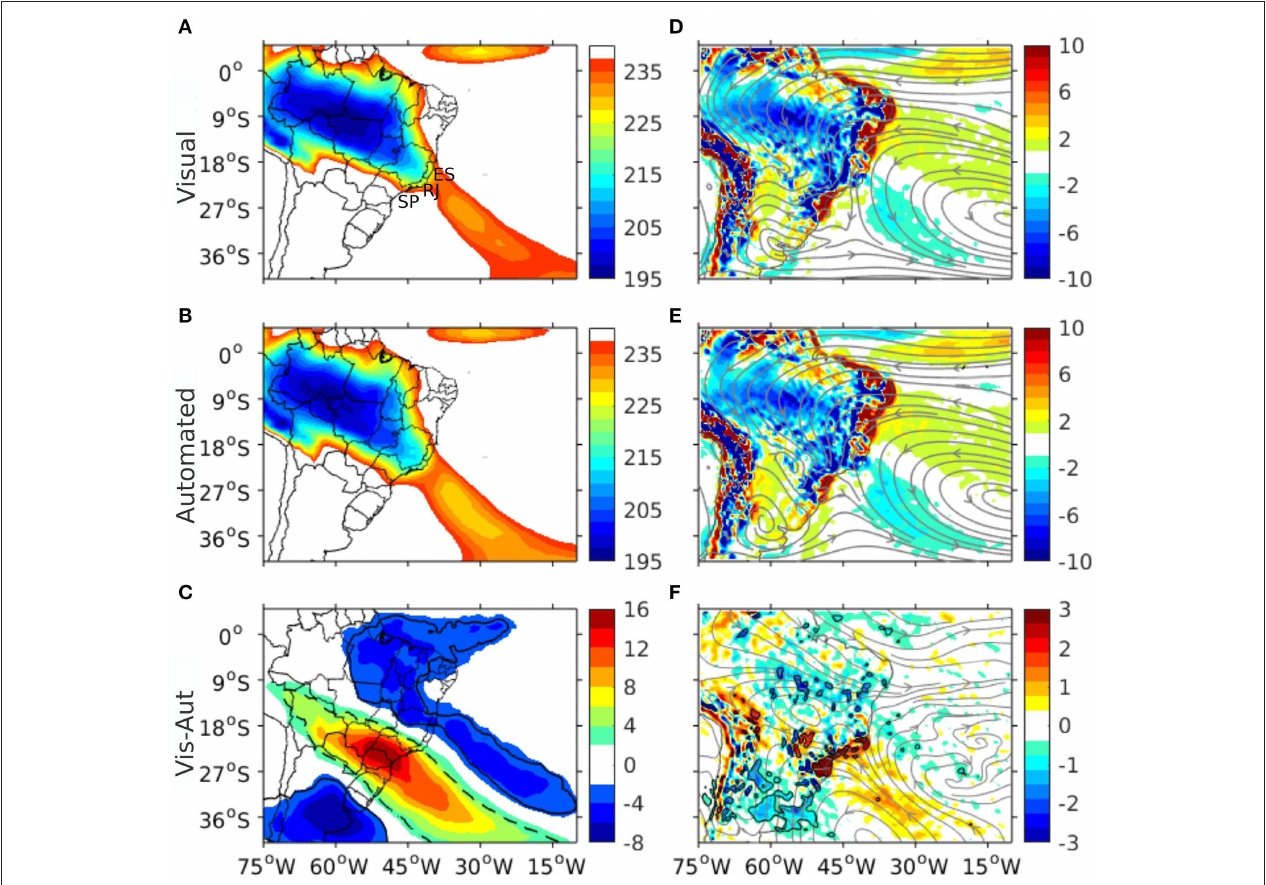
FIGURE 5 | Composites of active SACZ days of (A,B) OLR (W m − 2 ) and (D,E) divergence of water vapor flux (colors in × 10 8 s − 1 ) and streamlines in 850 hPa. (C,F) Are the difference between visual (A,D) and automated (B,E) methods with significant t -test values ( > 95%) inside the solid and dashed